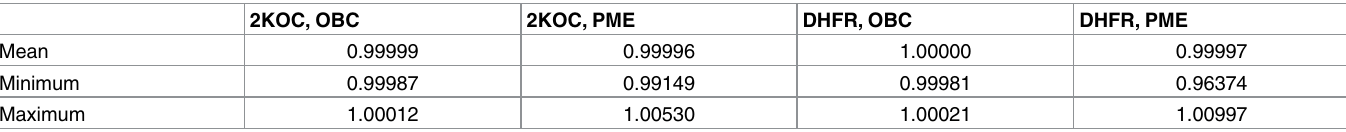
Table 7. Comparison of forces as computed by Amber and OpenMM. 2KOC, OBC 2KOC, PME DHFR, OBC DHFR, PME Mean Minimum Maximum 1.00012 1.00530 1.00021 1.00997 Values are the normalized projection of the Amber forces ( F A ) onto the OpenMM forces ( F O ): ( F A (cid:1) F O )/( F O (cid:1) F O ). The mean, minimum, and maximum are taken over all atoms.